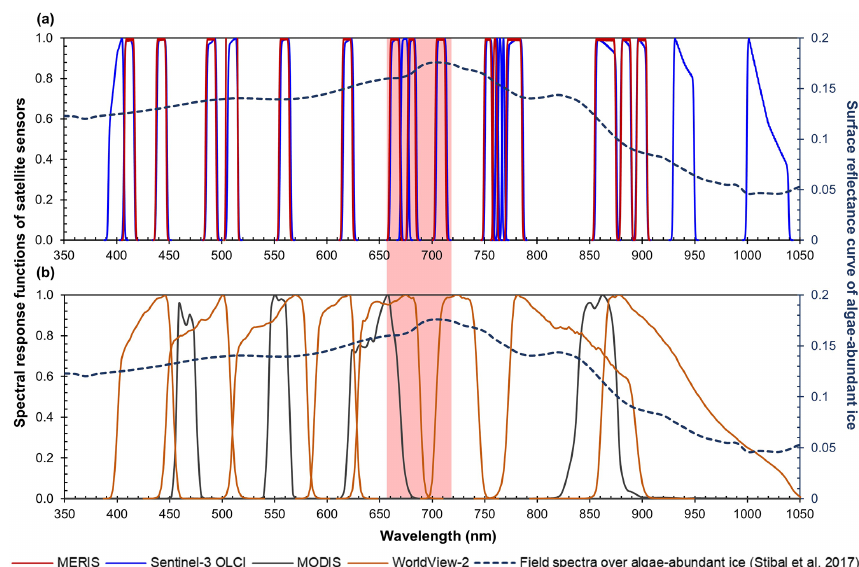
Figure 1. Spectral response functions of (a) MERIS (red) and OLCI (blue) and (b) MODIS (black) and WorldView-2 (orange) over the wavelength range of 350–1050nm. All the MERIS and OLCI bands are within the 350–1050nm range, where photosynthetic and photo- protective pigments have spectral responses. Four MODIS bands (over land) and eight WorldView-2 bands are within this spectral range but with much coarser spectral resolutions. In both subplots, the dashed line shows hyperspectral ASD field spectrometer data (right vertical axis) collected over algae-abundant ice by Stibal et al. (2017), containing chlorophyll a signal at the red–NIR wavelengths (red-highlighted region). The plotted field spectrum (sample code: Ab.25.06.14.D1) was measured on 25 June 2014 at 67 ◦ 04.779 (cid:48) N, 49 ◦ 24.077 (cid:48) W (near the automatic weather station S6 along the K-transect), with an algal abundance measurement of 121664cellsmL − 1 (Stibal et al.,